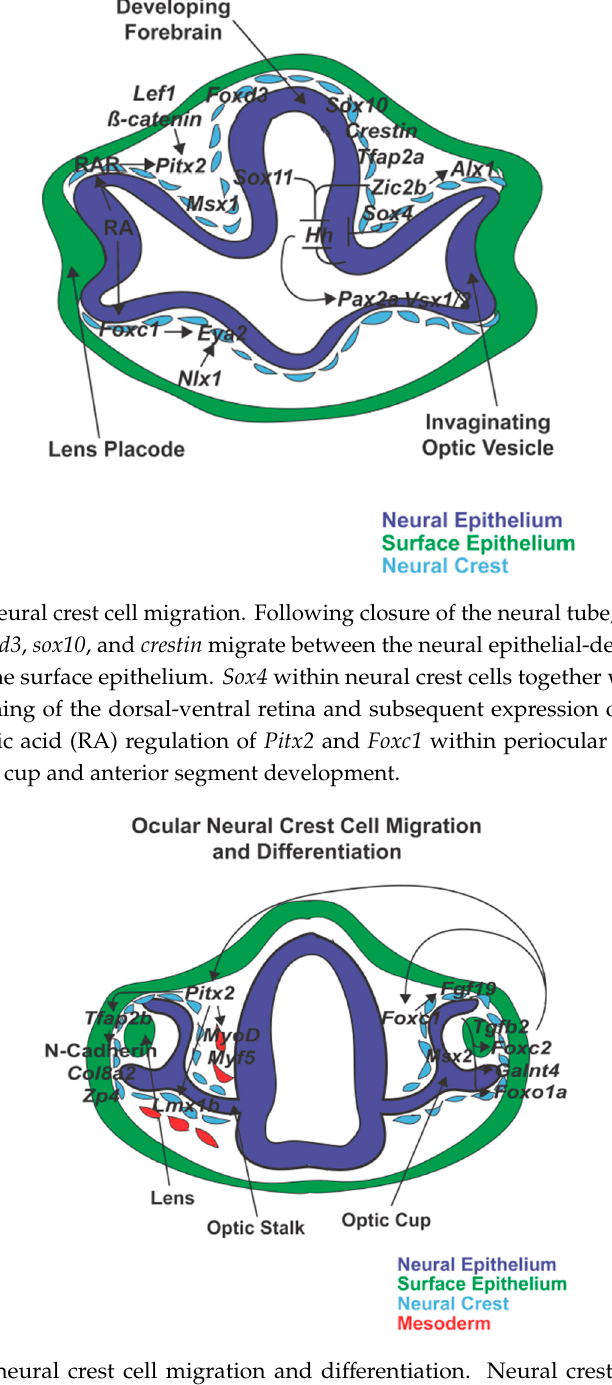
Figure 5. Ocular neural crest cell migration and differentiation. Neural crest cells surround the developing eye and enter into the ocular anterior segment between the surface epithelium and optic cup and through the ocular fissure. Pitx2 is important for corneal and iridocorneal angle development and function through the regulation of Tfap2b and Lmx1b. In addition, Pitx2 targets mesodermal cells and induces expression of MyoD and Myf5 which triggers extraocular muscle formation. Foxc1 also regulates anterior segment development by targeting Fgf19, Foxc2, GaInt4, and Foxo1a